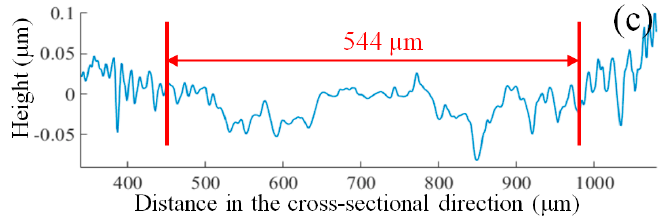
Figure 8. Cross-sectional profiles of the micro-grooves with a feed rate of ( a ) 0.4 µm/flute; ( b ) 0.8 µm/flute; and ( c ) 1.2 µm/flute.